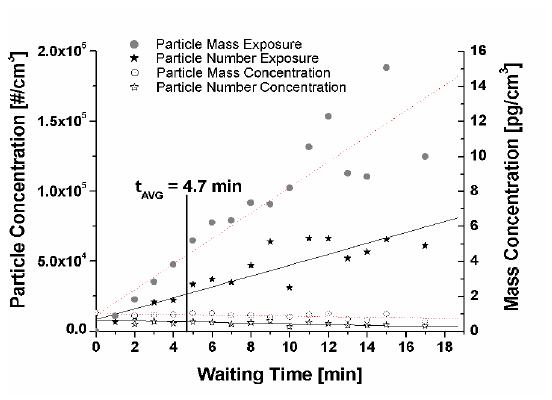
Figure 6 : Particle and mass concentrations as fractions of the passengers’ waiting times. Both particle and mass concentrations decline with time, whereas particle and mass exposure increase as passengers wait on the platform.